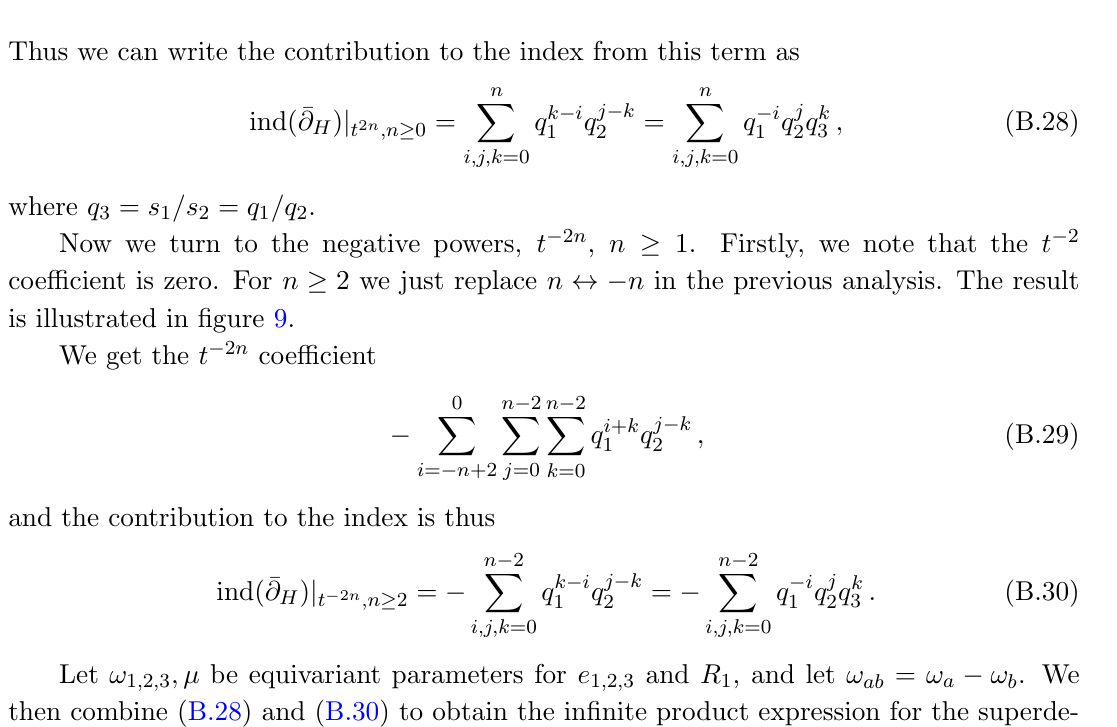
Figure 9 . Net result for the t (cid:0) 2 n -coe(cid:14)cient, n (cid:21) 2, after